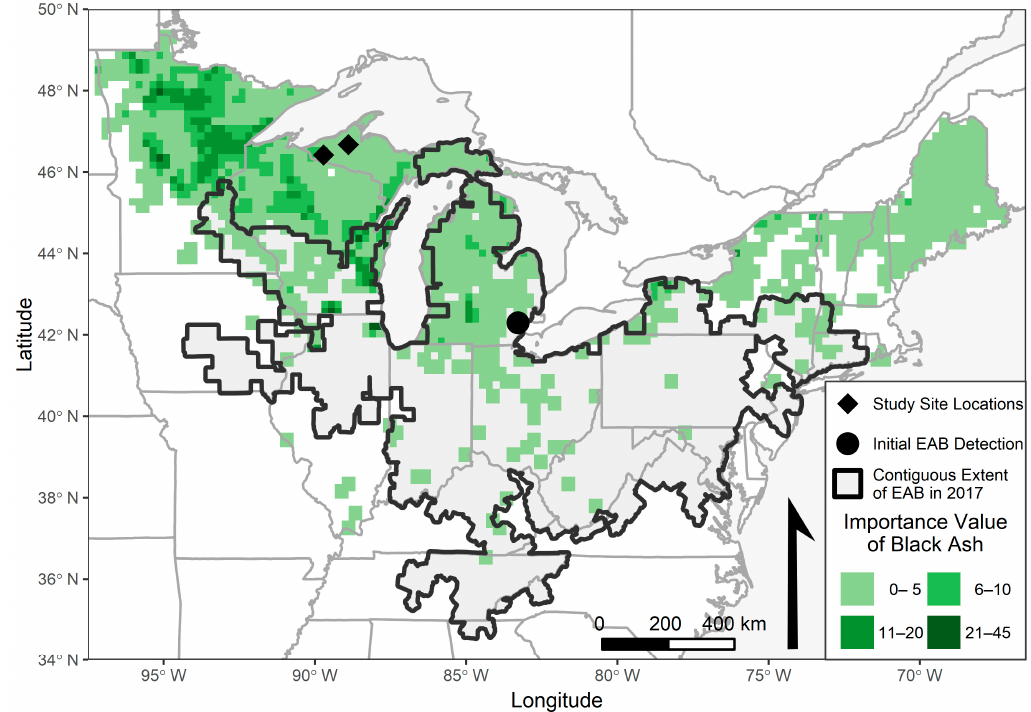
Figure 1. Extent of contiguous counties with detected emerald ash borer in 2017 [26] and the current Importance Value of black ash in the United States derived from US Forest Service Forest Inventory and Analysis data [7]. Initial Emerald ash borer (EAB) detection in Wayne County, Michigan, USA (2002) and study site locations also shown.